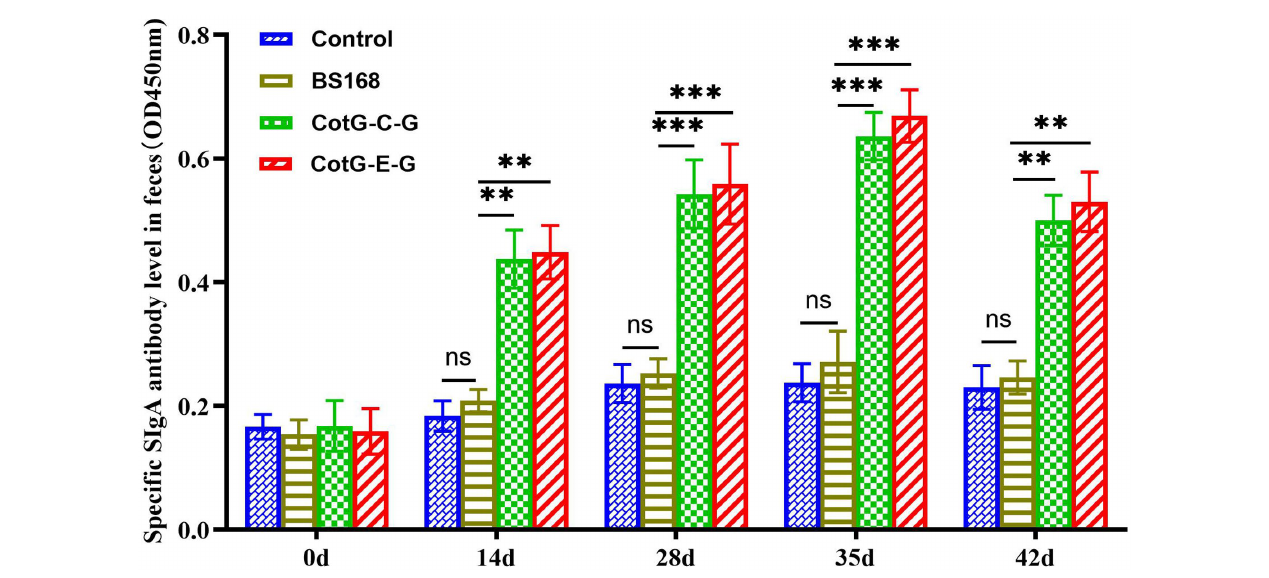
FIGURE 3 Detection of specific SIgA mucosal levels. The feces of mice ( n = 8) were collected at 0, 14, 28, 35 and 42 days after the first vaccination, and the specific SIgA (the value of OD450 nm was calculated) level was detected by indirect ELISA. Data are presented as mean ± SD for each group (* p < 0.05, ** p < 0.01, *** p < 0.001, **** p < 0.0001).